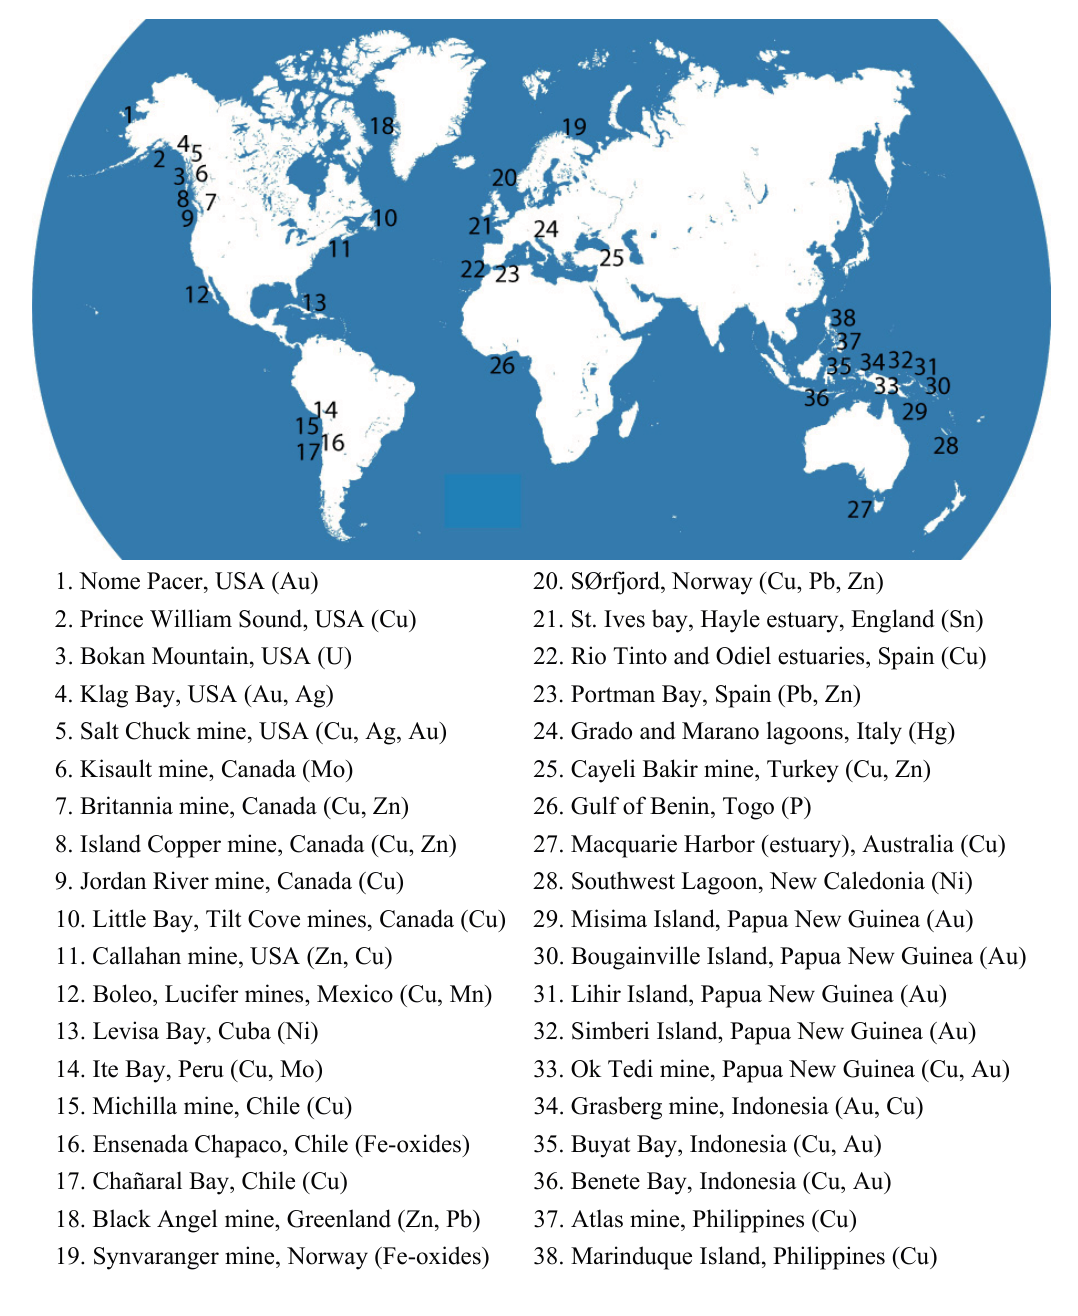
Figure 1. Locations of coastal areas impacted by tailings deposition (including shore deposition, shallow, and deep-sea disposal). In brackets are the economically exploited metals. Adapted from Koski